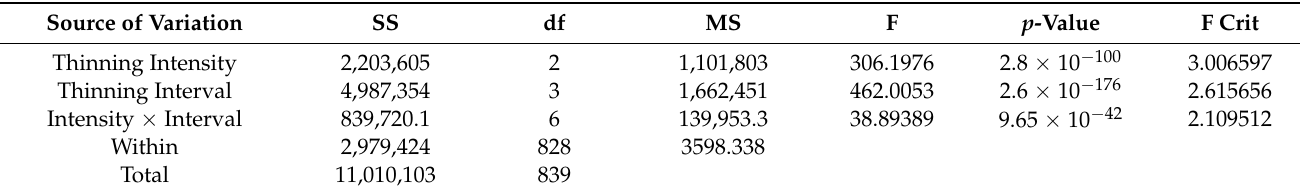
Table A3. Two-way ANOVA test for stand biomass.